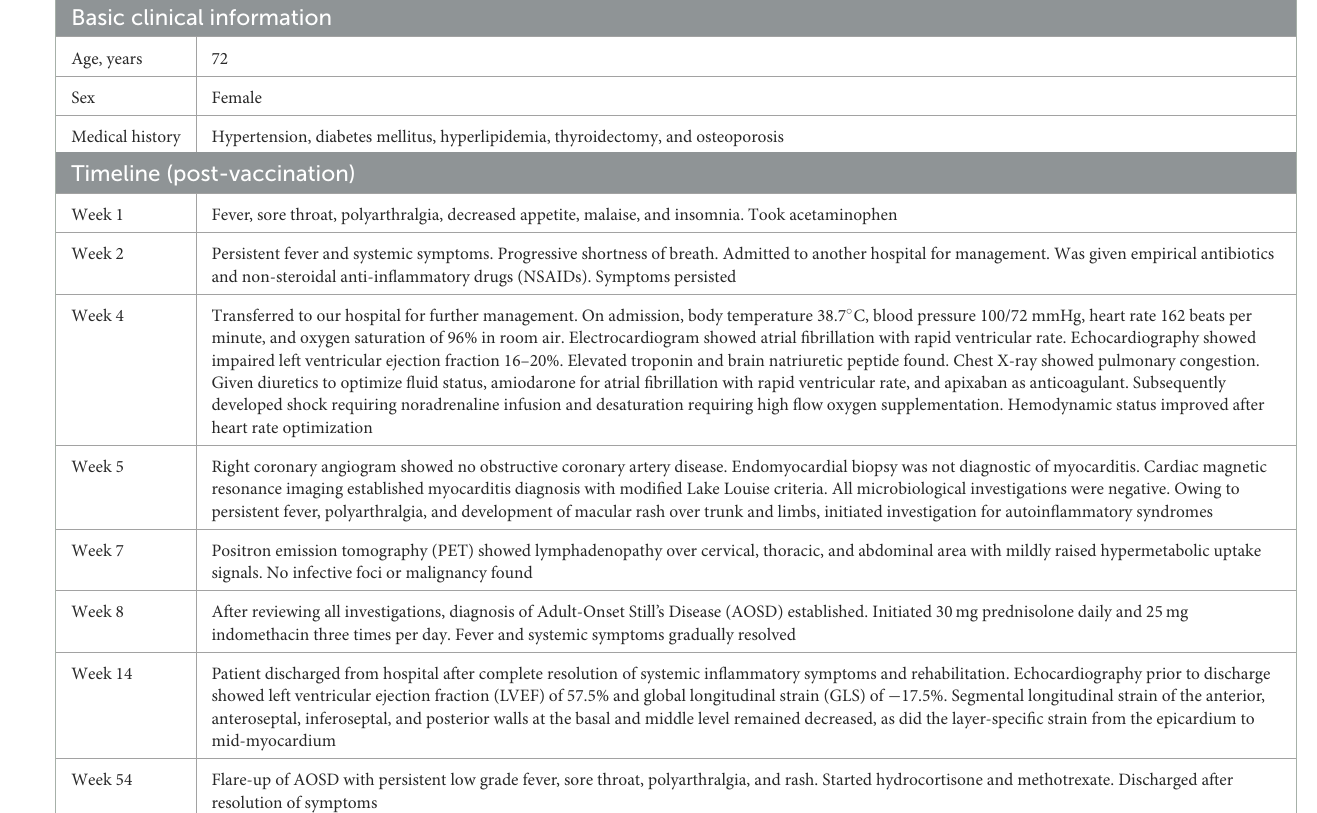
TABLE 1 Baseline clinical condition and